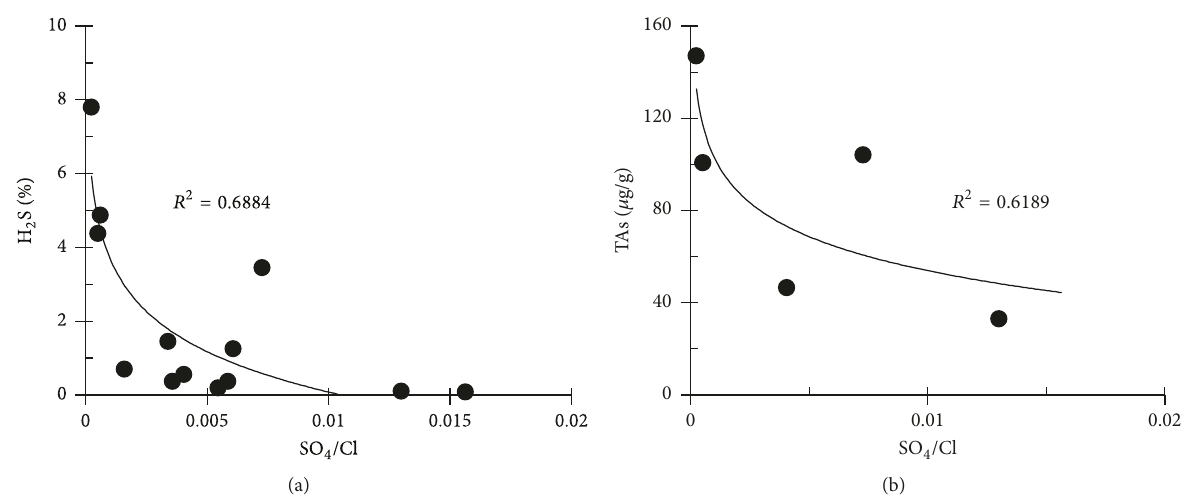
Figure 6: Relationship between (a) SO 4 /Cl ratios and H 2 S concentrations; (b) SO 4 /Cl ratios and TAs